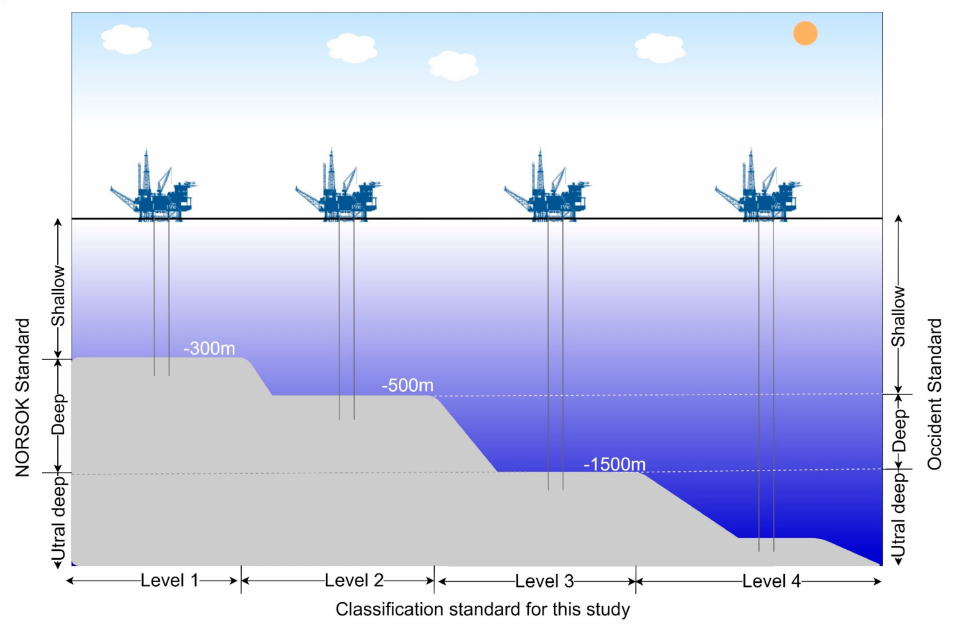
Figure 7. Depth classification for offshore HE in this study. Level 1: ≥− 300 m, Level 2: − 300 m >